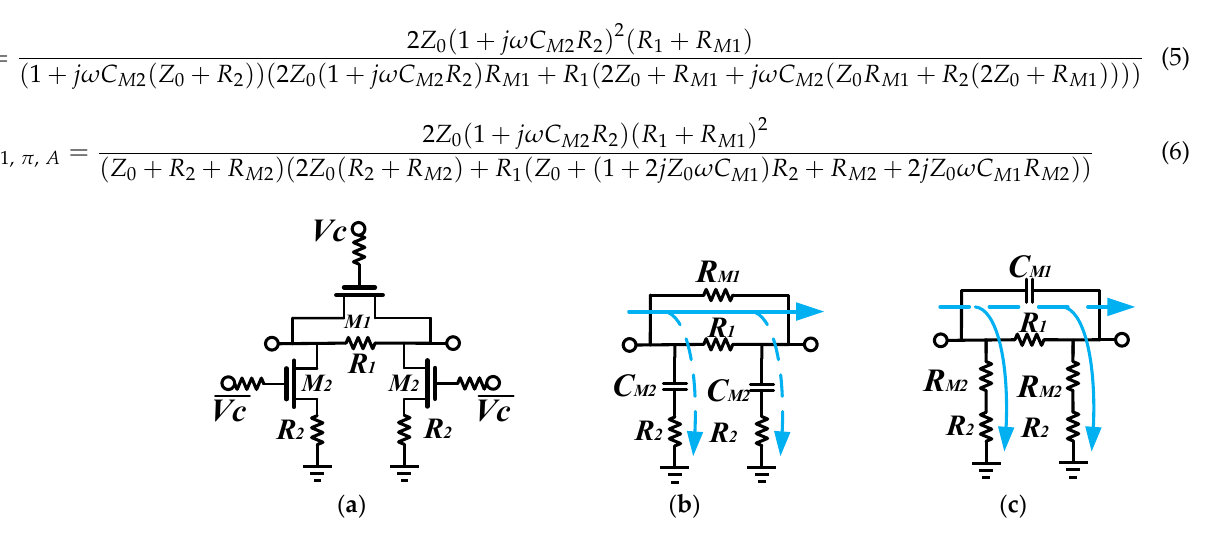
Figure 6. ( a ) The schematic of the conventional switched π -type attenuation cell. ( b ) Reference state. ( c ) Attenuation state.